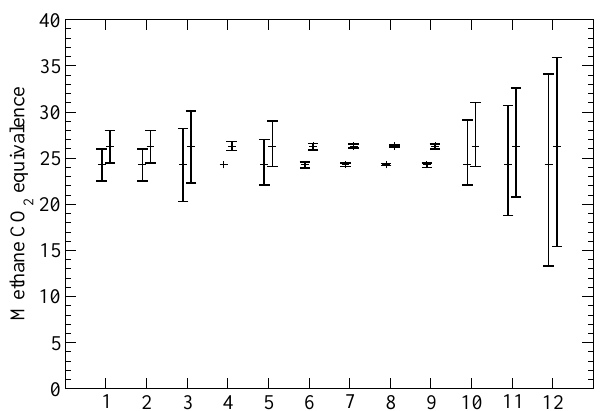
Fig.2. UncertaintyrangeinthemethaneGDP withoutandwithmethaneconversionwhenindividualparametersfromTable1(listedfrom1 Fig. 2. Uncertainty range in the methane GDP without and with to 12) are varied within the ranges specified in the Table and all otherparameters are held to theircentral values. The central values are 24.3 methane conversion when individual parameters from Table 1 and 26.3 without and with CH 4 conversion to CO 2 , respectively. (listed from 1 to 12) are varied within the ranges specified in the table and all other parameters are held to their central values. The central values are 24.3 and 26.3 without and with CH 4 conversion to CO 2 ,